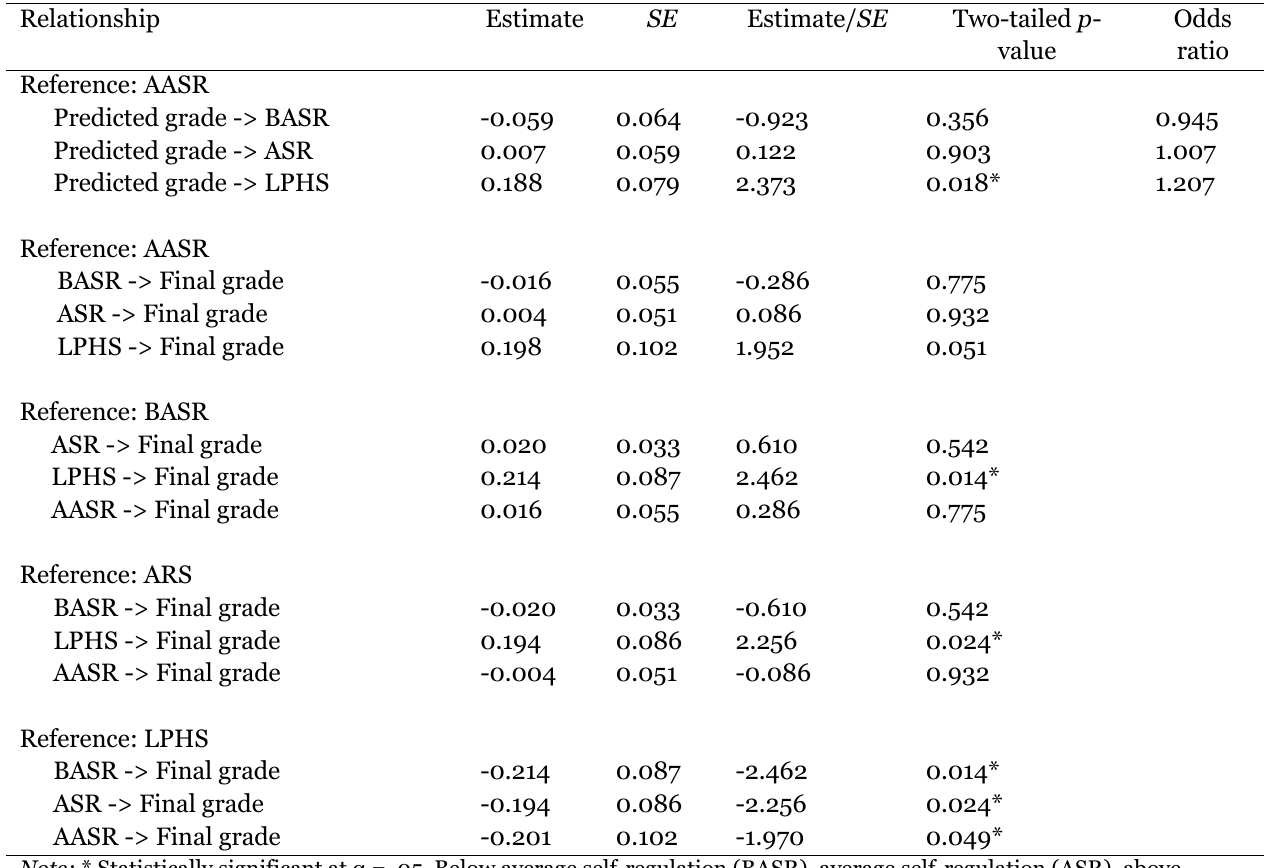
Relationships between Latent Profiles, Predicted Grade, and the Course Grade